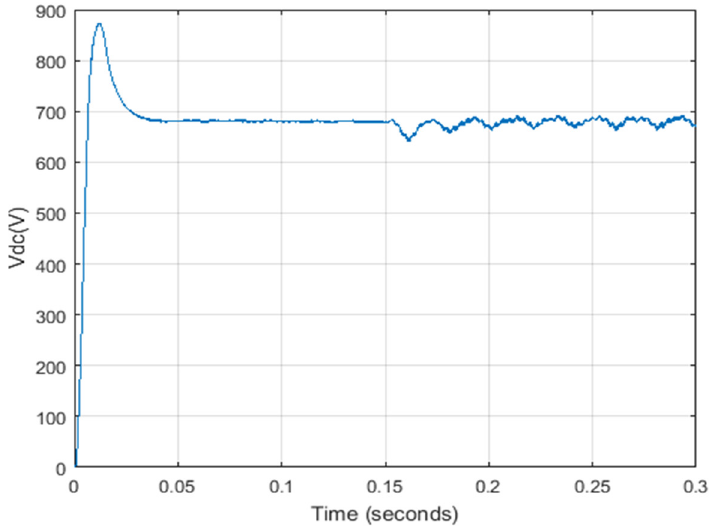
Figure 6. DC voltage in scenario 1.